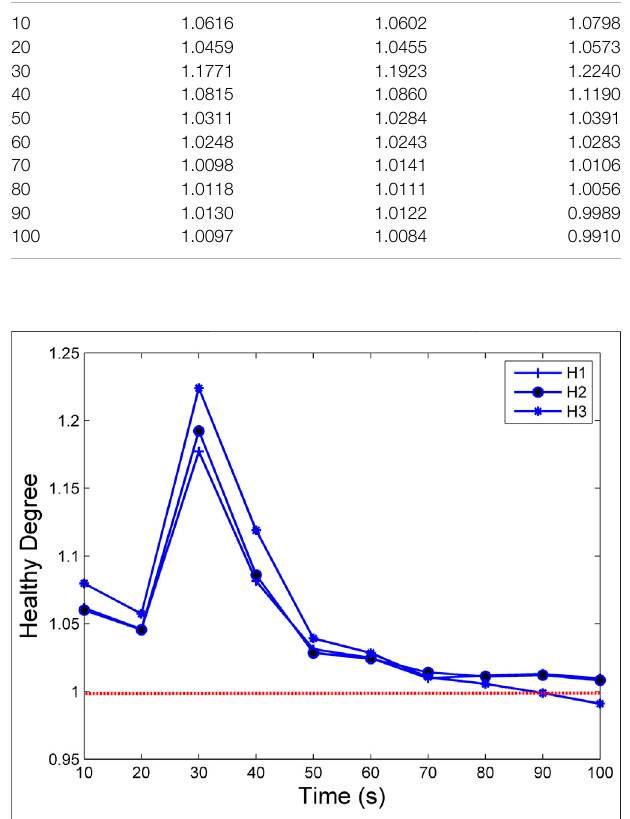
FIGURE 3 | Fault prediction curves of engine equipment from normal operation to fault 3. It is obvious that only the fault prediction curve of fault 3 whose healthy degree starts to be less than 1 when the time is close to 90 s, and the healthy degree decreases with